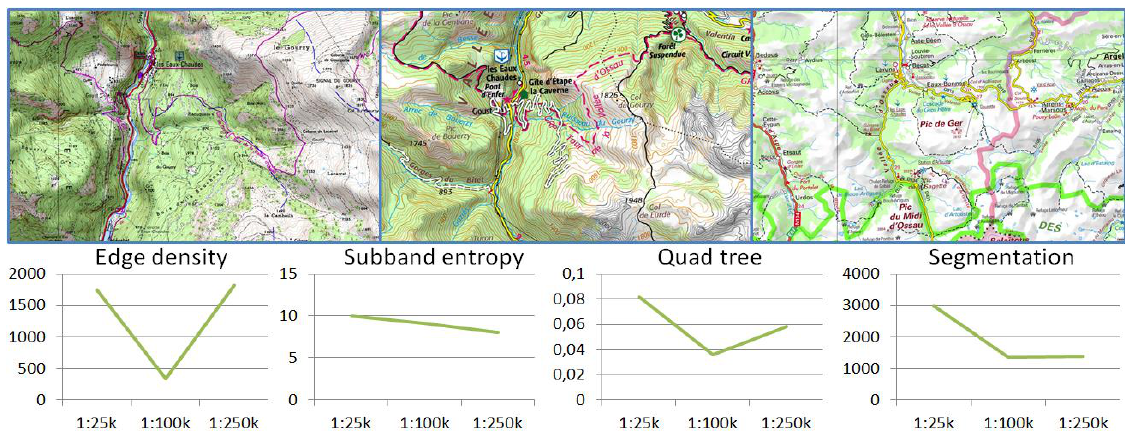
Figure 10. Evolution of clutter when scale decreases in a mountain area